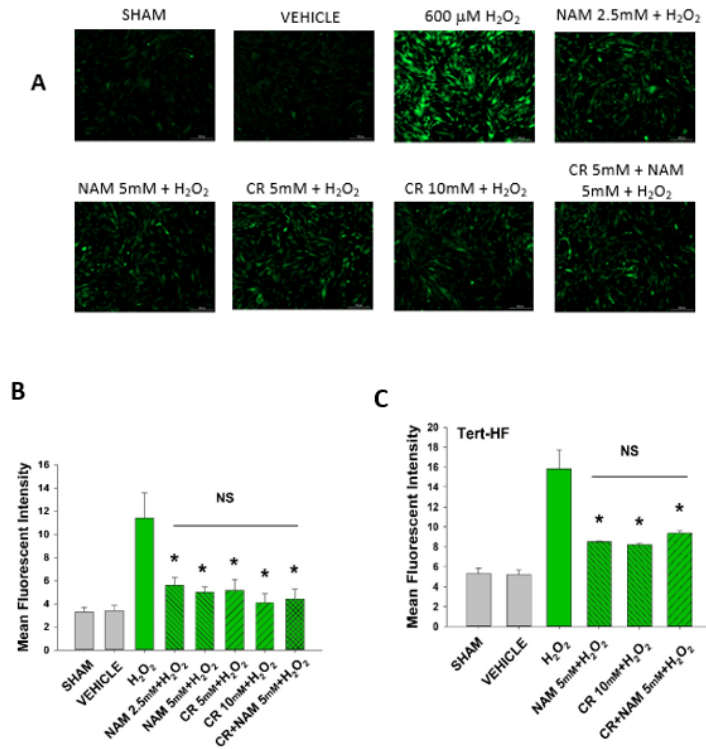
Figure 8. Effect of Cr and NAM pretreatment on oxidant induced ROS generation in DHF and Tert-HF. ( A ) Representative pictures of DCFH2-DA staining of vehicle versus 30 min 600 mM H 2 O 2 treatment versus pretreatment for 24 h with CR or NAM alone or combined (5 mM each) in DHF. Cells were harvested at 30 min post oxidant treatment; ( B , C ) graphical representation of mean fluorescence intensity of ( B ) DHF or ( C ) Tert-HF. The data are mean ± SE from triplicate experiments. * Denotes statistically significant changes in the Cr/NAM treated levels in comparison to H 2 O 2 alone. NS, the treatments compared are not statistically significantly different.